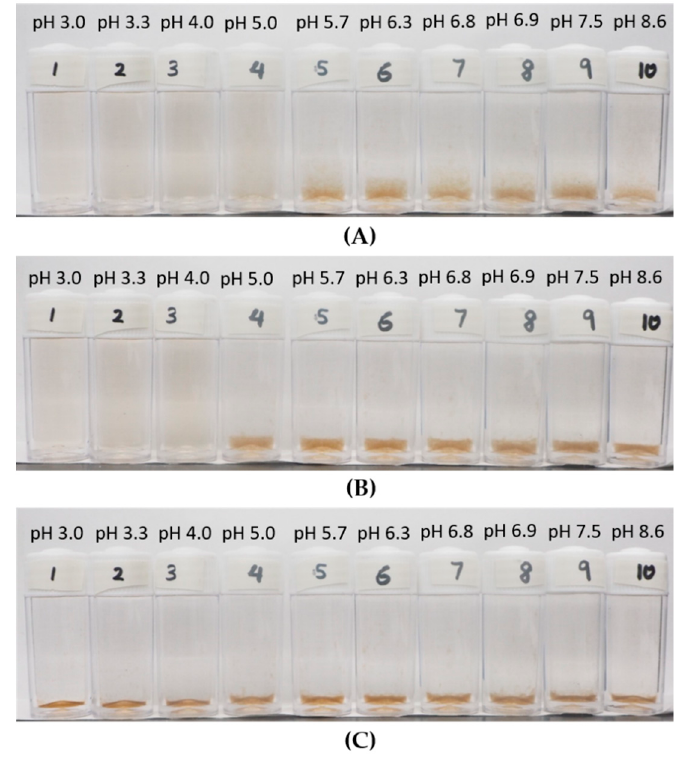
Figure 5. Macroscopic view for the LSZ–LHA complex at mass ratio C LSZ / C LHA = 5 at 10 mM KCl concentration over pH. The time frame images are after 2 h ( A ), after 3 h ( B ) and after 24 h ( C ).